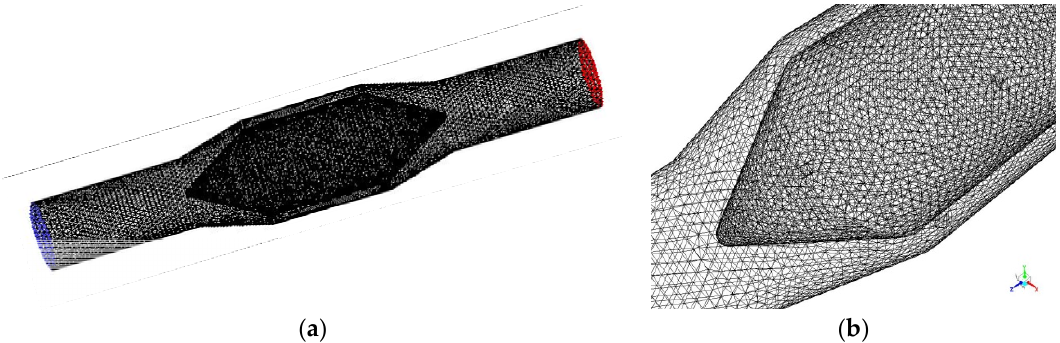
Figure 9. ( a ) Flowmeter mesh distribution; ( b ) Mesh distribution in the cone-shape flow restriction area.